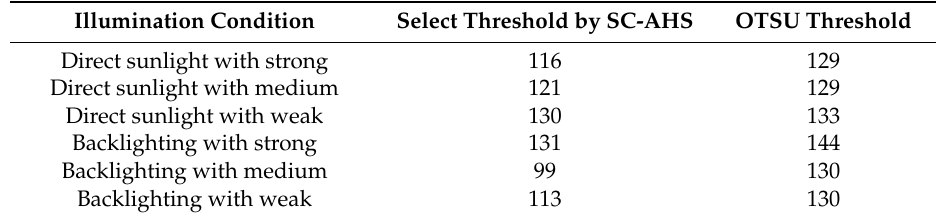
Table 8. Comparison of thresholds selected from the non-dominated solution set under six illumination conditions with OTSU thresholds.